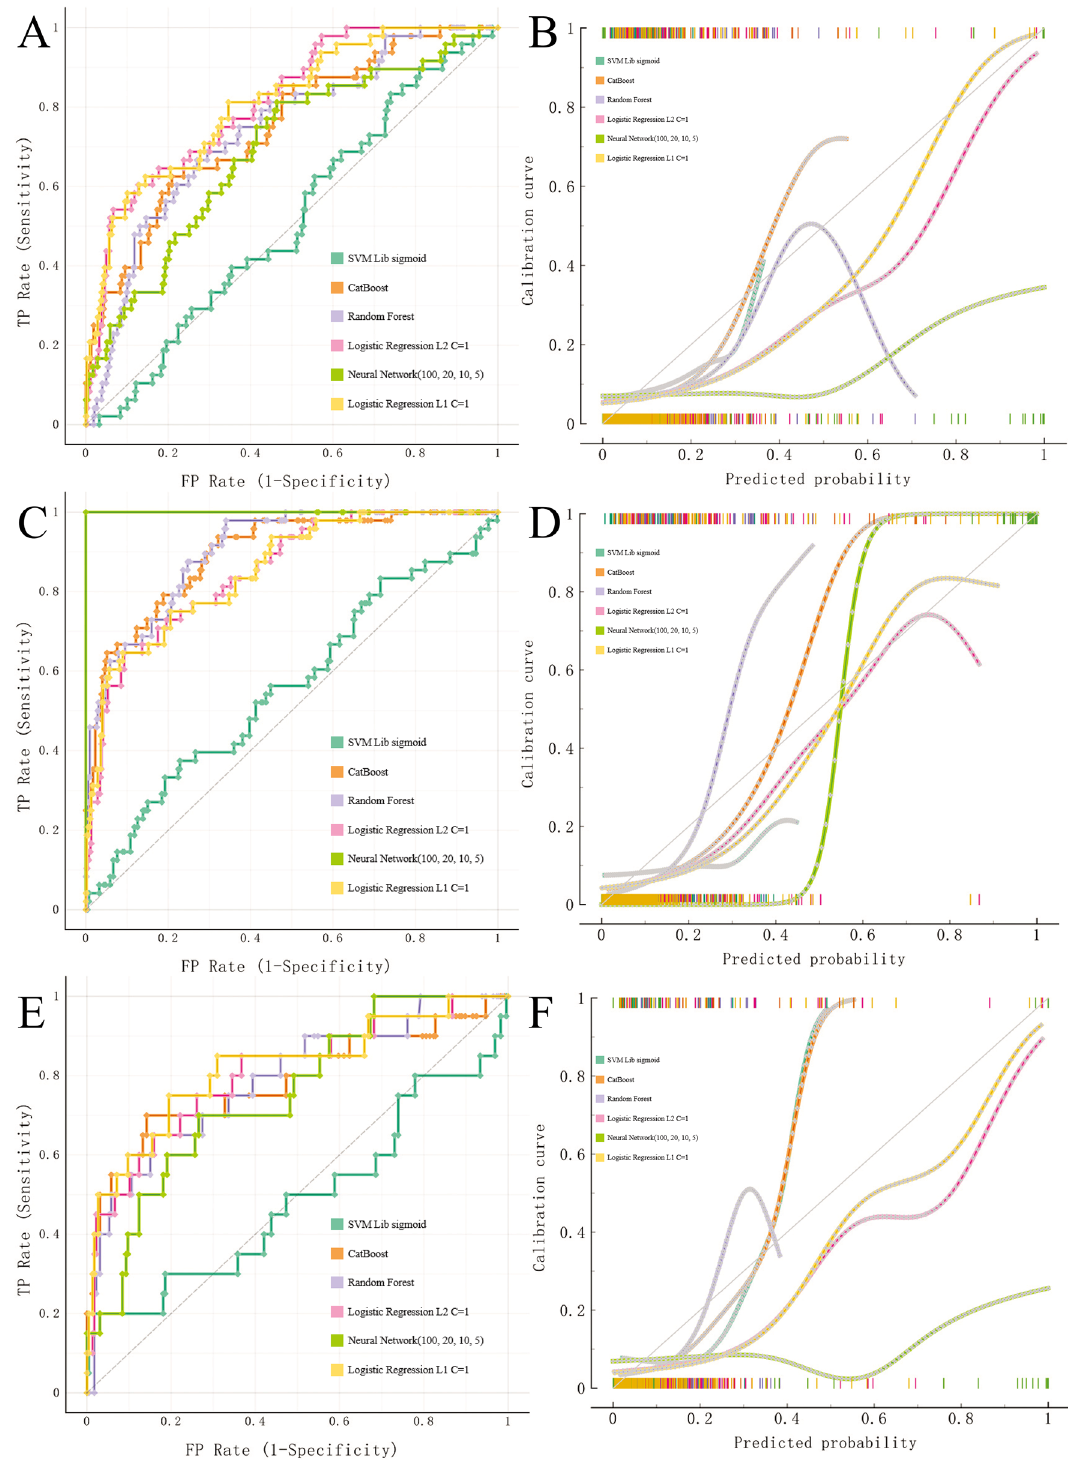
Figure 2. Model performance. Fivefold cross-validation was used to evaluate model performance in the training set. ROC curves and calibration curves were used to compare the strengths and weaknesses of the models. ( A , B ) ROC andibration curves of the five machine learning models on the training set using fivefold cross-validation. ( C , D ) internal validation on the training set. ( E , F ) ROC andibration curves of the five machine learning models in the test set. From Supplementary Table 4, we can find that the model obtained by Logistic Regression (L1 regularization) performs best with AUC = 0.819, F1 = 0.357 in the validation